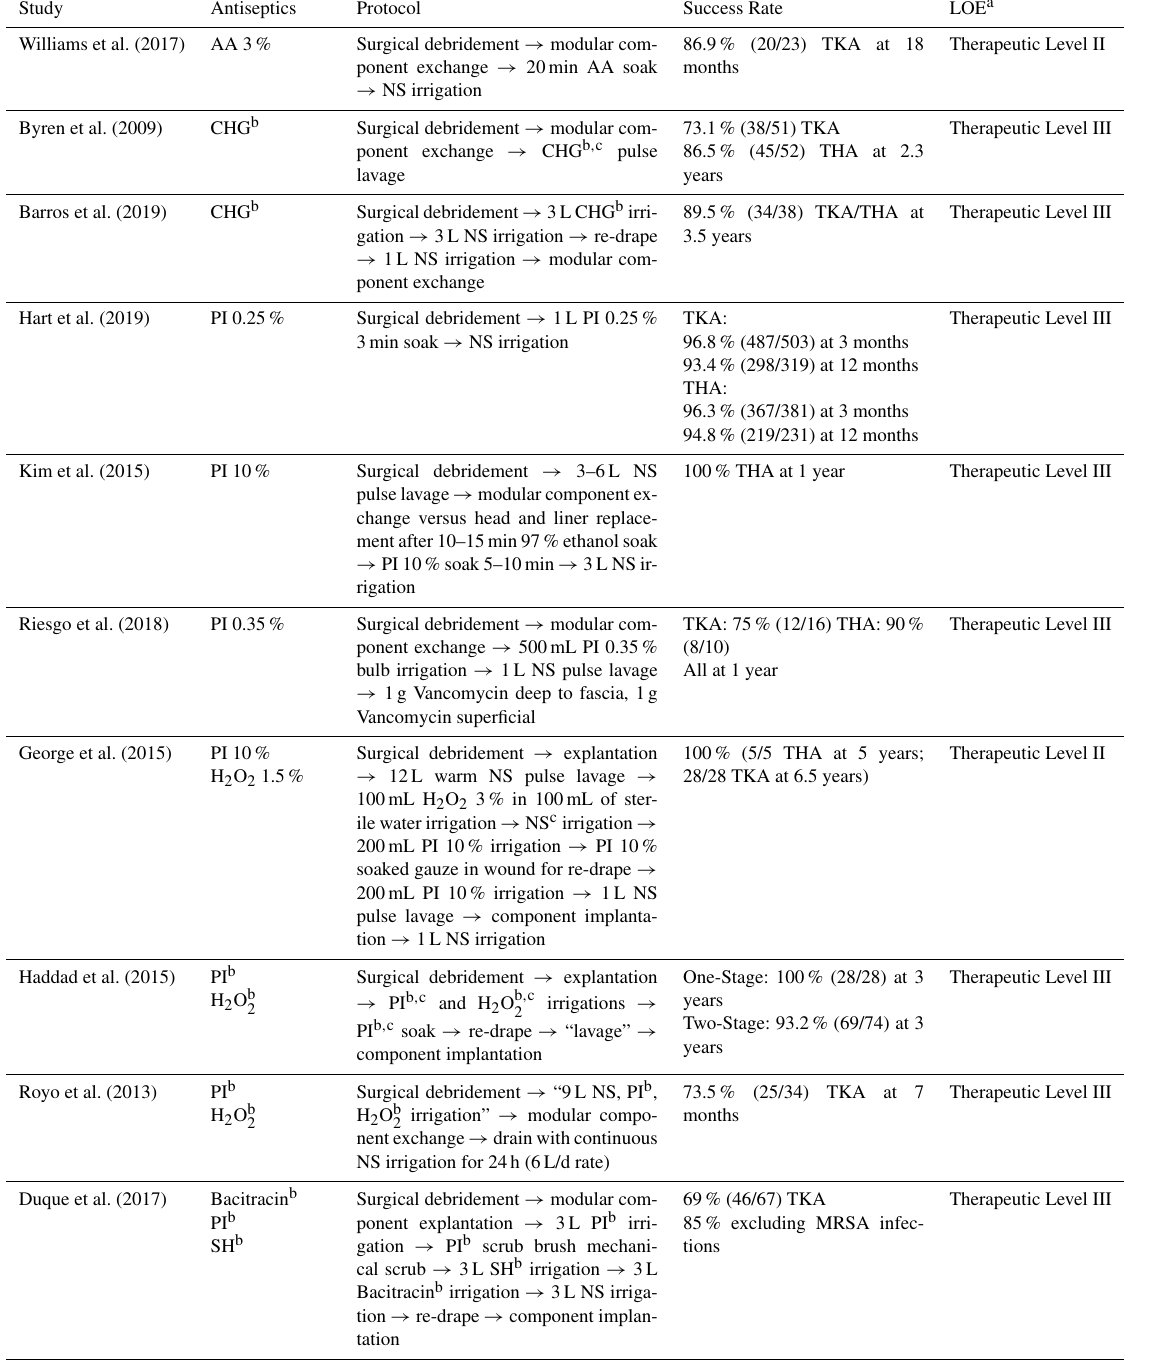
Table 4. Antiseptic irrigation protocols in the